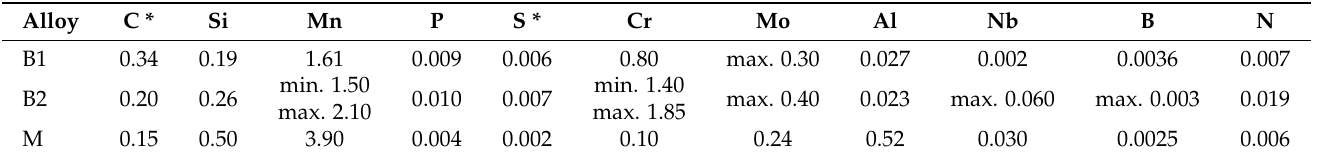
Table 1. Chemical compositions of the investigated steels determined by spark spectral analysis. The steels of type 35MnCrB6-4 (modified 33MnCrB5-2/1.7185), 19MnCrMo7-6 (1.7971) and 15MnSi16-